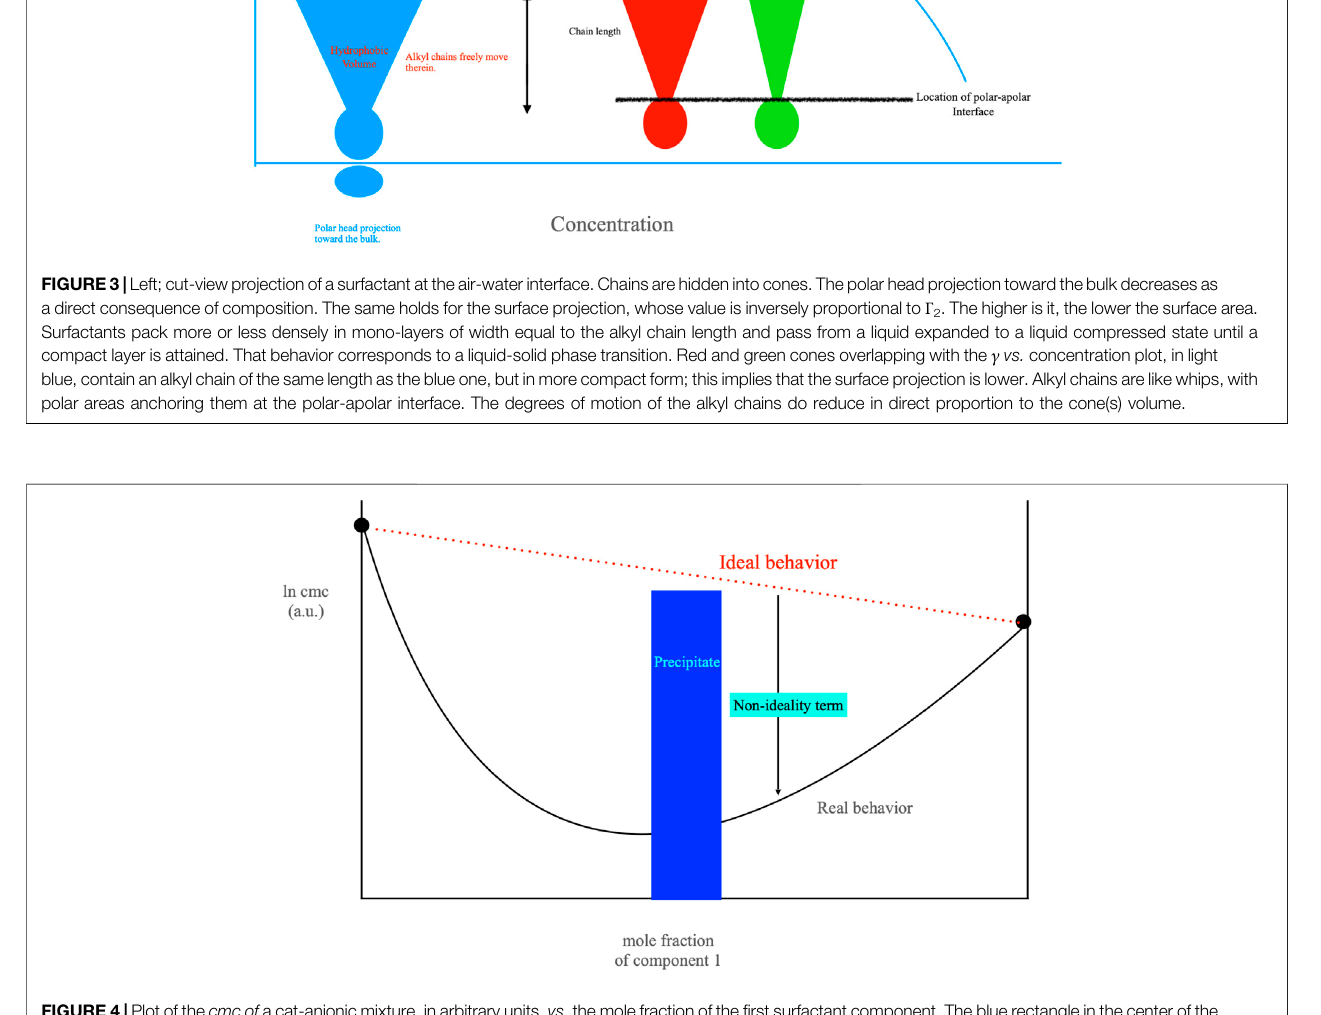
FIGURE 4 | Plot of the cmc of a cat-anionic mixture, in arbitrary units, vs. the mole fraction ofthe fi rst surfactant component. The blue rectangle in the center of the fi gureindicatesthelocationoftheprecipitatearea,where Cat + An − solidsoccur.Thereddottedlineindicatesthebehaviorexpectedifidealmixingweretooccurwhereas the down-pointing arrow (in black) indicates the non-ideal effects. Data are based on the sodium dodecylsulfate/cetyltrimethylammonium bromide system, at 25.0 ° C. Component 1 in the plot is sodium dodecylsulfate. The black line indicated as Real behavior was drawn imposing the ß parameter (of value − 21.0 kJ mol − 1 ) to be